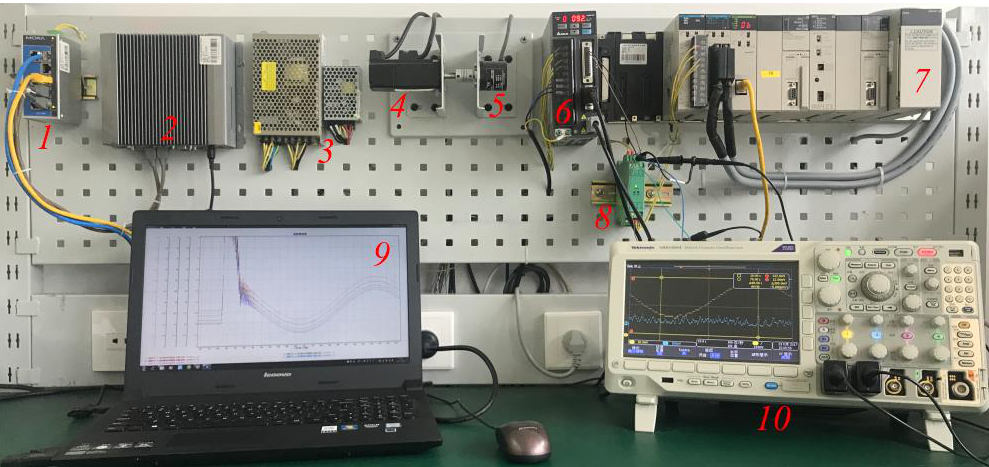
Figure 10. Components of the experimental setup. 1: Router, 2: IPC, 3: 10V and 5V power supply, 4: Servo motor, 5: Optical electrical rotary encoder, 6: Server driver, 7: PLC, 8: D/A channels, 9: Engineer station, 10: Oscilloscope.